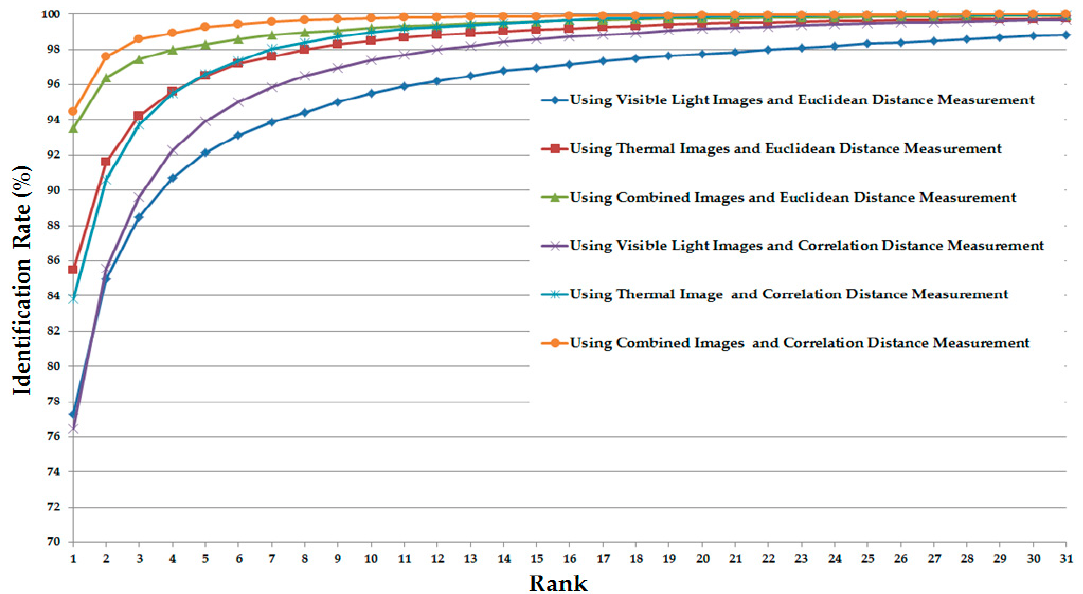
Figure 17. CMC curves of the identification systems that use the head part for the identification problem.